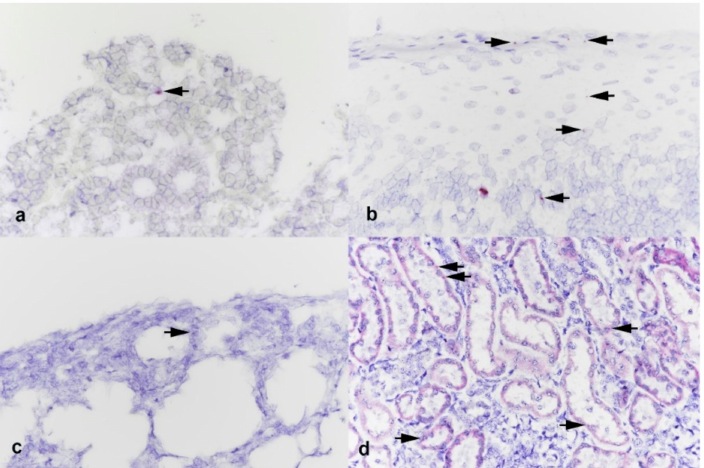
Figure 2. Photomicrographs of ( a ) turbinate, ( b ) tonsil, ( c ) lung, and ( d ) kidney from piglets experi- mentally inoculated with SARS-CoV-2. In turbinates rare labeling of ACE2 RNA was seen associated with submucosal glands (arrow). Labeling in the tonsil was visible in cells of various layers of the stratified squamous epithelium (arrows). While rare ACE2 RNA expression was noted in pulmonary interstitium (arrow), more moderate expression was noted in renal tubular epithelial cells (arrows). BaseScope ISH ACE2. Magnification = 40 ×